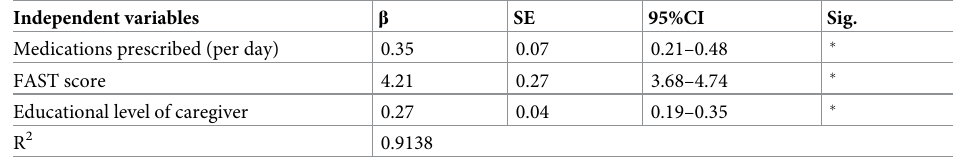
Table 6. Regression model for global costs due to dementia. Brazil,